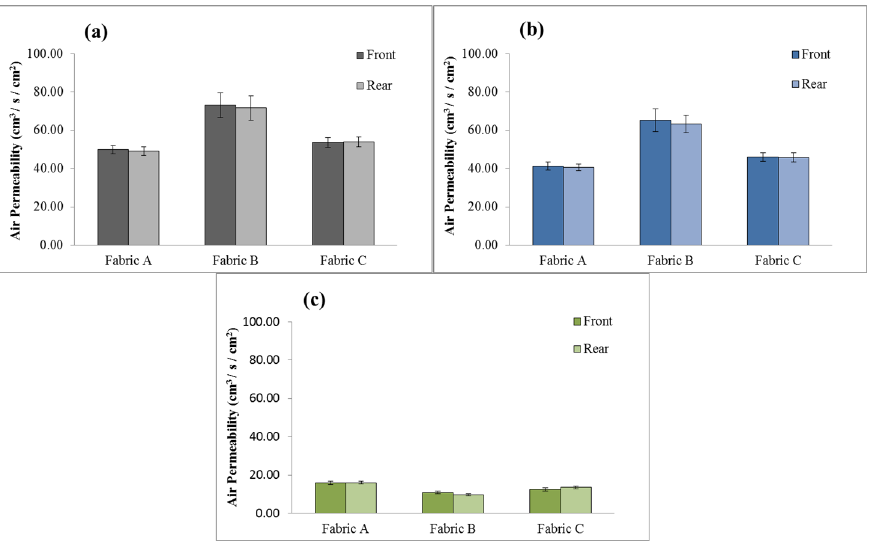
Figure 8. Air permeability of elastic warp-knitted fabrics (Fabrics A, B, and C) made by BC ( a ); PC ( b ) and BPC ( c ) ring-spun complex yarns.